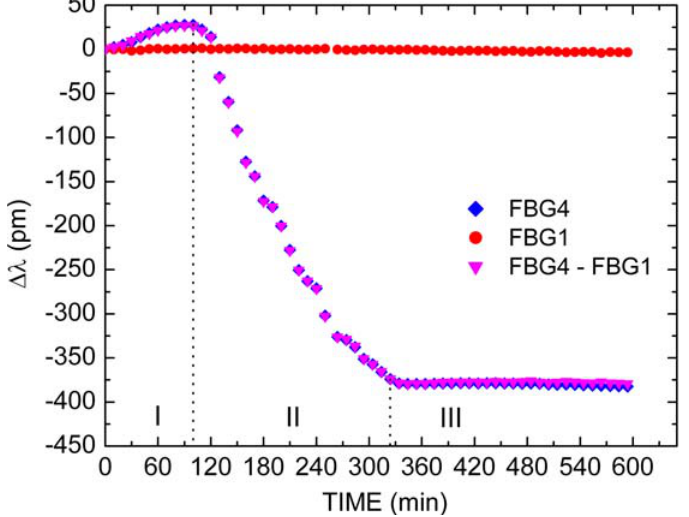
Figure 7. FBG1, packaged FBG4 and thermal compensated FBG4 responses as function of time during the Paint2 drying